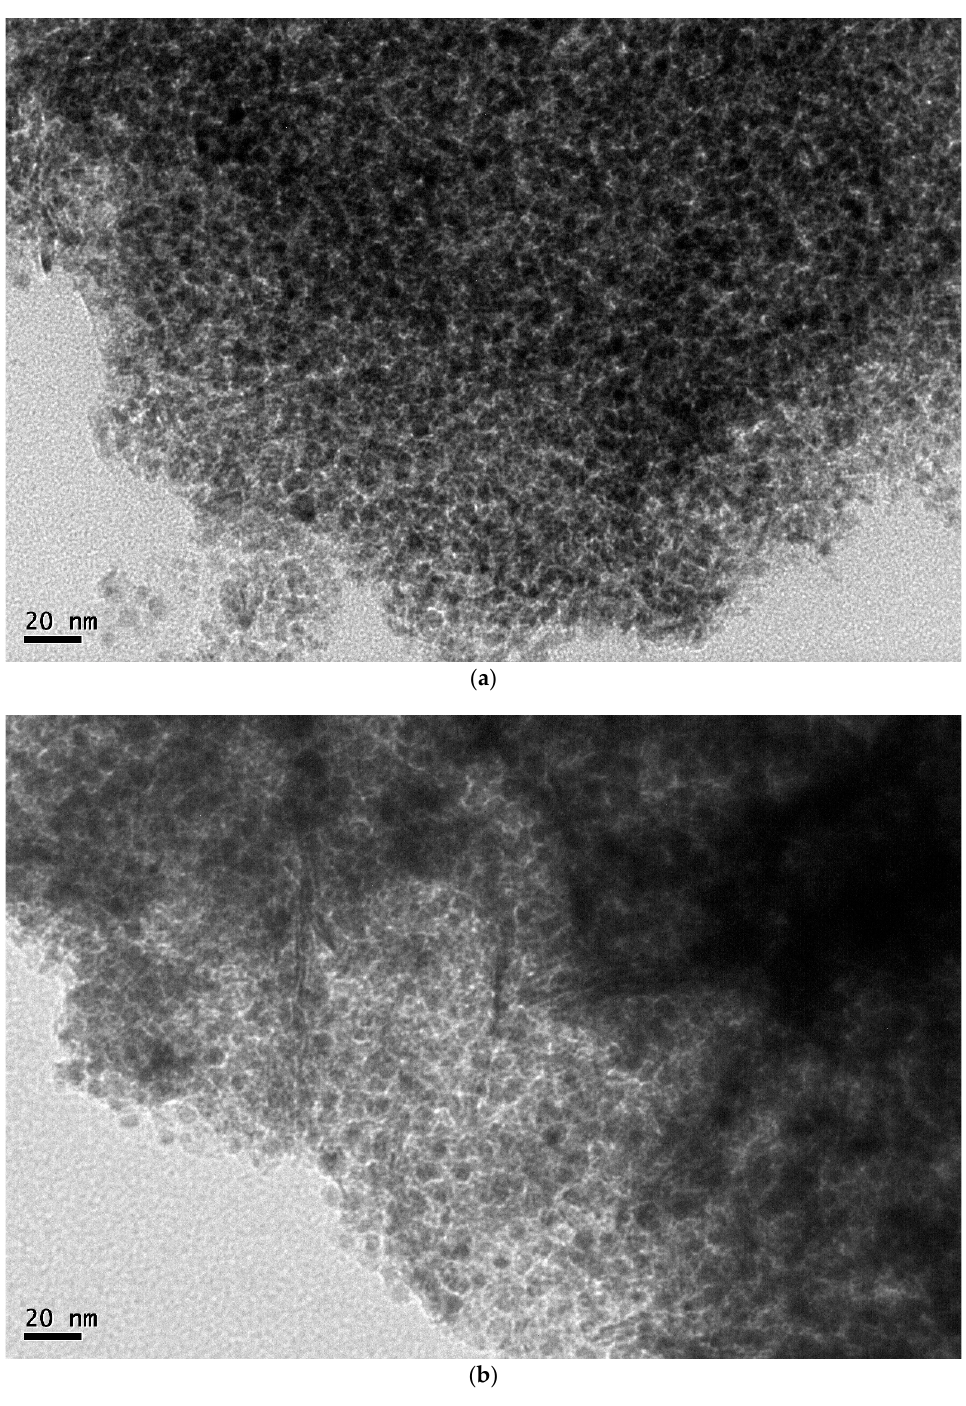
Figure 5. TEM images of the used Ni/Al 2 O 3 ( a ) and Ni 2 P/Al 2 O 3 ( b ) catalyst.